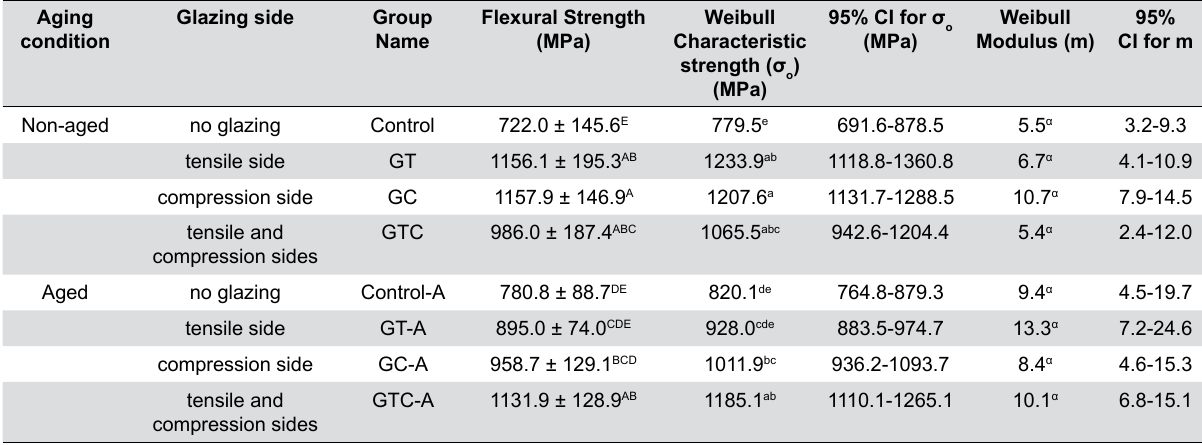
Table 1- Mean flexural strength (MPa) with standard deviation, characteristic strength (σo), Weibull modulus (m) and respective CI (95%) for biaxial flexure strength of experimental groups